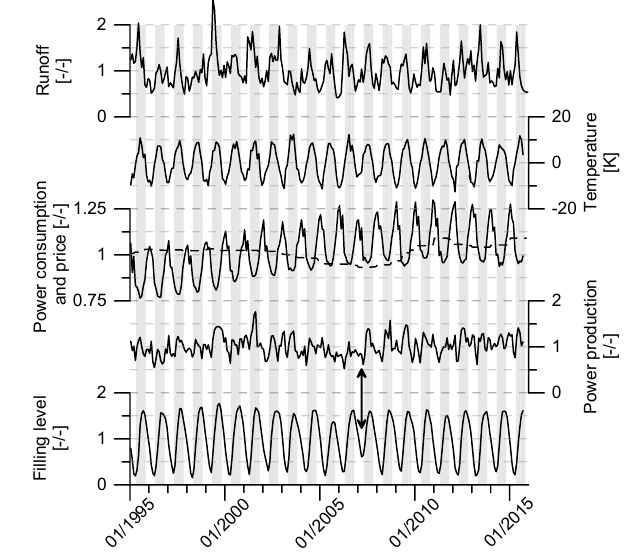
Figure 3. Time series of monthly water storage filling level, wa- ter power generation, electricity consumption/prices, and hydrom- eteorological conditions in Switzerland since 1995. All data were converted to anomalies with respect to their averages of the period 1995–2010. (dashed line: Electricity consumer price index; shad- ing indicates hydrological seasons with white = winter; the arrow marks a singularity in winter 2006/07) (Data sources: cf. Table